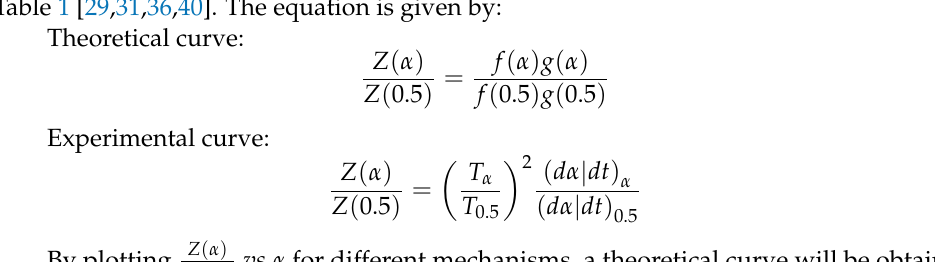
Theoretical curve: